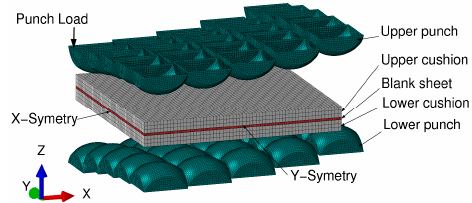
Figure 2. Finite element model for saddle shape.